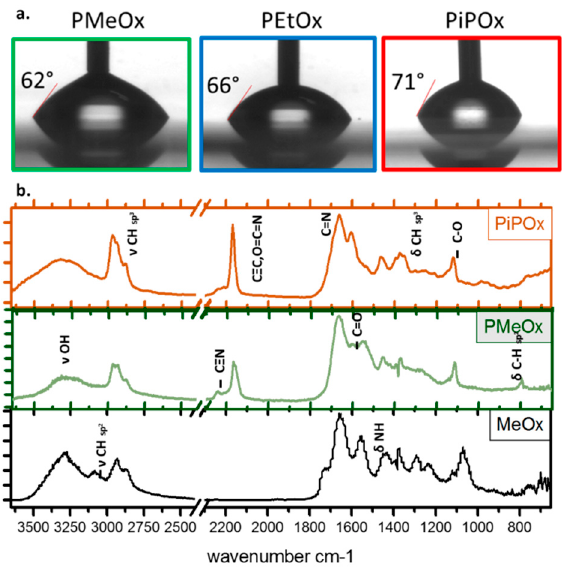
Figure 3. ( a ) Advancing water contact angle of water in air on plasma-deposited Methyl, Ethyl, and isopropenyl oxazoline deposited at 50 W and 2.3 mbar. ( b ) FTIR spectra of isopropenyl, and methyl oxazoline deposited under the same conditions as well as a pristine methyl oxazoline precursor.